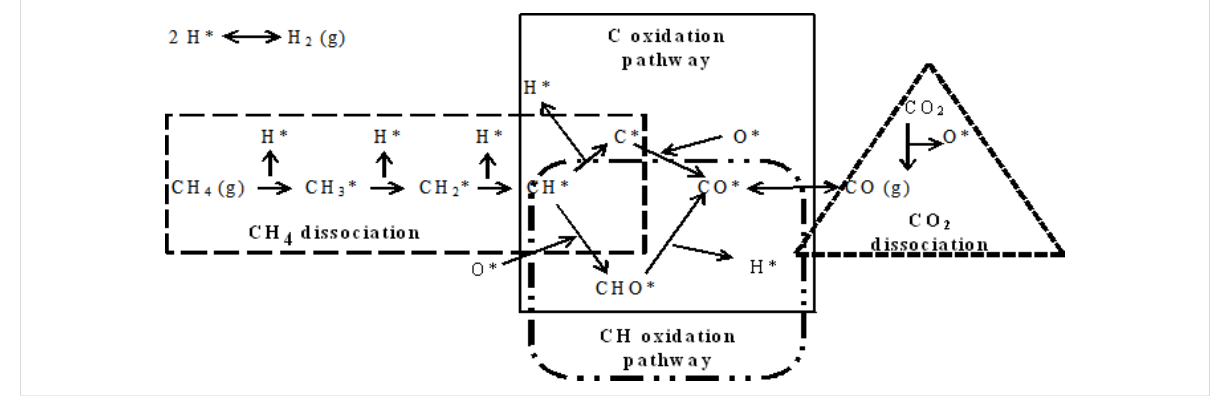
Figure 2: A schematic diagram of the DRM reaction on Ni metal. Adapted from [73].